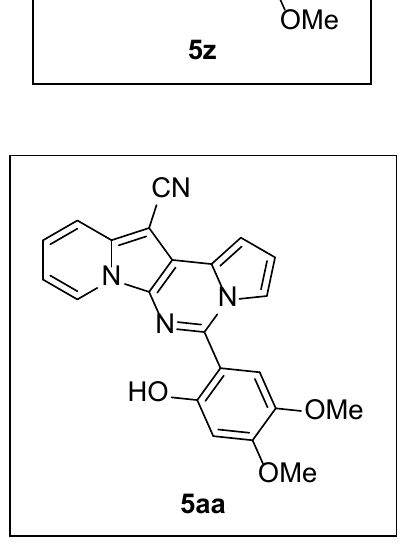
5-(2-Hydroxy-4-methoxyphenyl)pyrrolo[1 ′ ,2 ′ :1,6]pyrimido[5,4- b ]indolizine-12-car- bonitrile (5z). Yellow solid, mp: 235.7–236.4 °C (34.7 mg, 89%); 1 H NMR (400 MHz, CDCl 3 ) δ 10.31 (s, 1H), 8.57 (d, J = 6.8 Hz, 1H), 7.96 (s, 1H), 7.94 (d, J = 7.2 Hz, 1H), 7.75 (d, J = 8.8 Hz, 1H), 7.31–7.27 (m, 1H), 7.16 (d, J = 2.4 Hz, 1H), 6.98–6.93 (m, 2H), 6.70 (d, J = 2.4 Hz, 1H), 6.64 (dd, J = 8.8 Hz, 2.4 Hz, 1H), 3.90 (s, 3H); 13 C{ 1 H} NMR (100 MHz, CDCl 3 ) δ 162.9, 158.6, 142.7, 138.0, 128.8, 127.9, 126.3, 125.2, 122.9, 117.6, 116.0, 115.8, 115.4, 113.1, 111.3, 109.9, 106.8, 102.5, 102.0, 72.6, 55.5; HRMS (ESI-QTOF) m / z